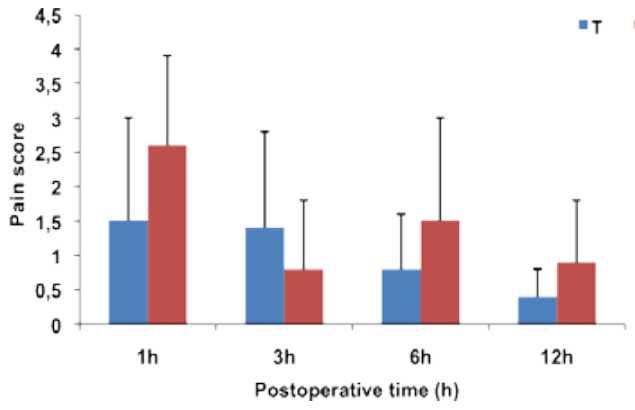
FIGURE 1 - Mean±SD pain scores in dogs treated with tramadol (T) and morphine (M) at each time postoperative period.